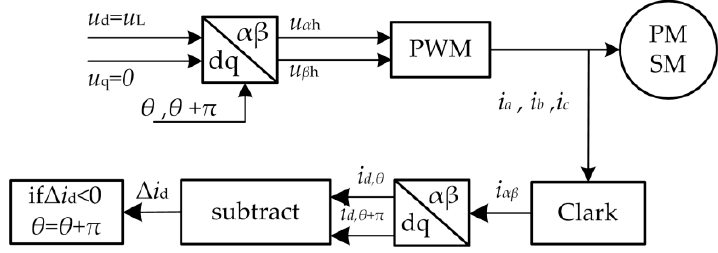
Figure 10. Relationship of stator magnetic potential and flux.